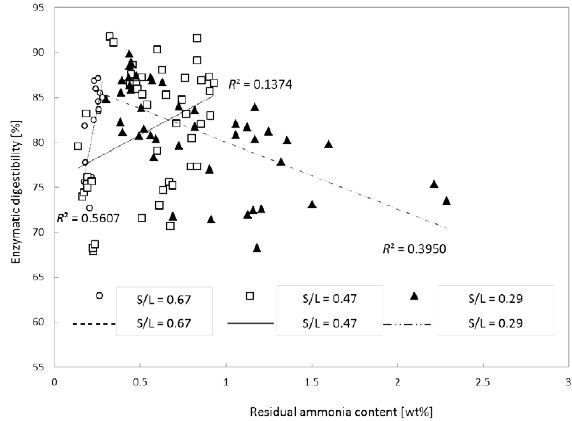
Figure 5. Effects of residual ammonia content on glucan digestibility of pretreated corn stover. Pretreatment: 0.08, 0.16 or 0.24 (g NH 3 )/(g biomass), S/L ratio = 0.29, 0.47 or 0.67, 24–120 h, 90–150 ◦ C. Enzymatic hydrolysis: 15 (FPU CTec2)/(g glucan) loading, 50 ◦ C, 150 rpm, 72